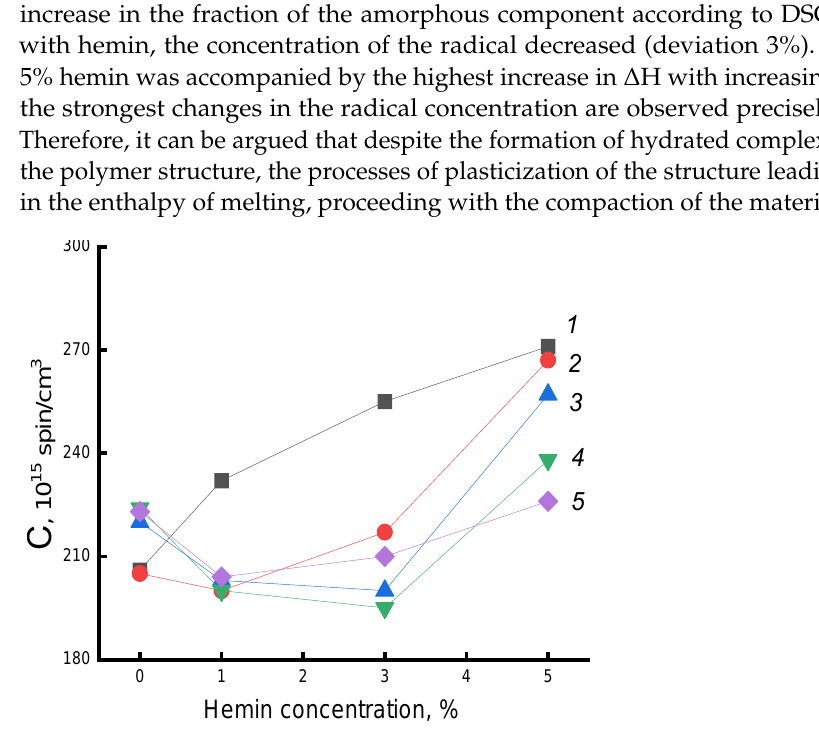
Figure 8. Dependence of the C radical concentration in PHB/hemin on the concentration of the additive. Exposure time in the aquatic environment at 70 °C: 1 — 0, 2 — 30, 3 — 50, 4 — 90, 5 — 300 min.